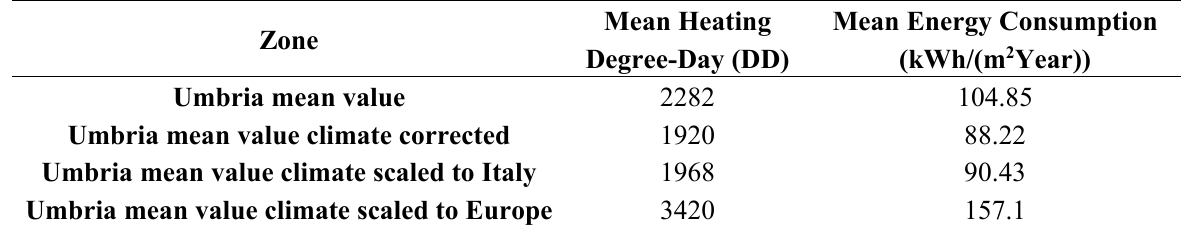
Table 5. Mean energy consumption of Umbria buildings corrected with climate normalization.